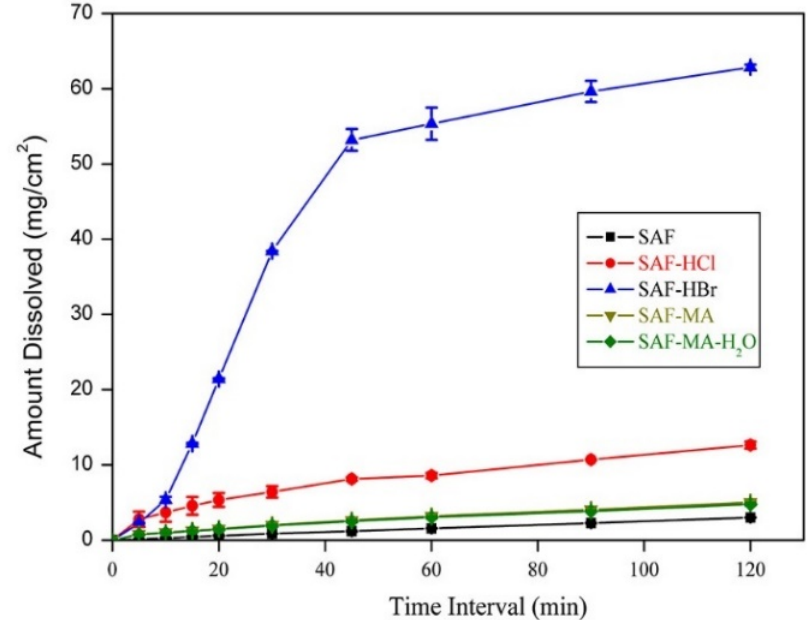
Figure 10. Dissolution profiles for SAF, SAF-HCl, SAF-HBr, SAF-MA and SAF-MA-H 2 O in phosphate buffer pH 6.86 at 37 °C.